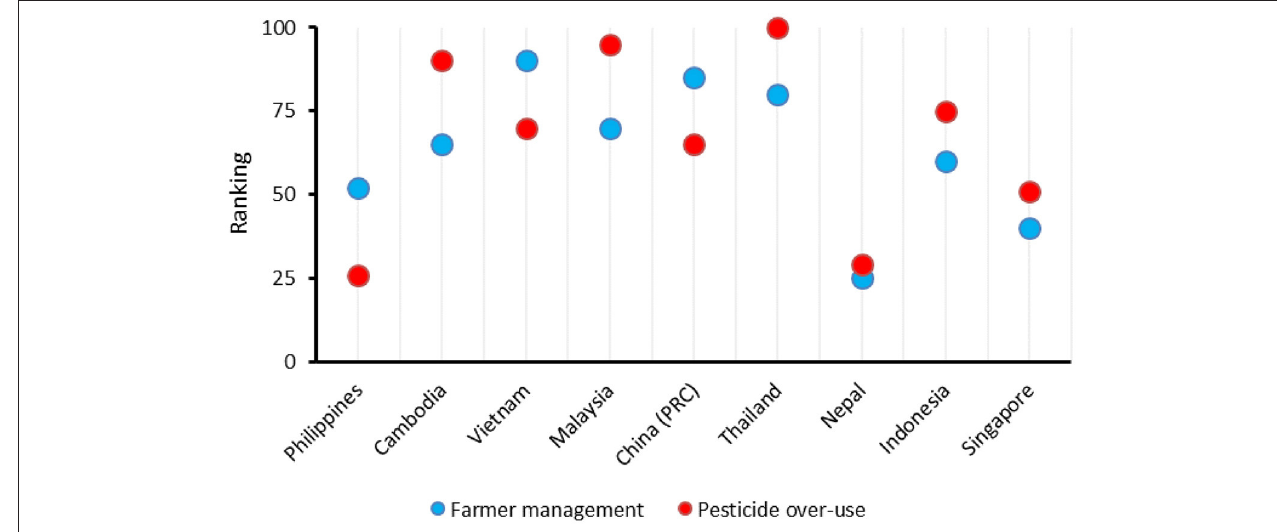
FIGURE 2 | Country-level perceptions regarding farmers’ pest management and the extent of pesticide over-use. Patterns are plotted for nine different Asia-Pacific countries. Both variables are ranked on a scale from 0 to 100, with 100 either reflecting “very good management” or “significant over-use”.